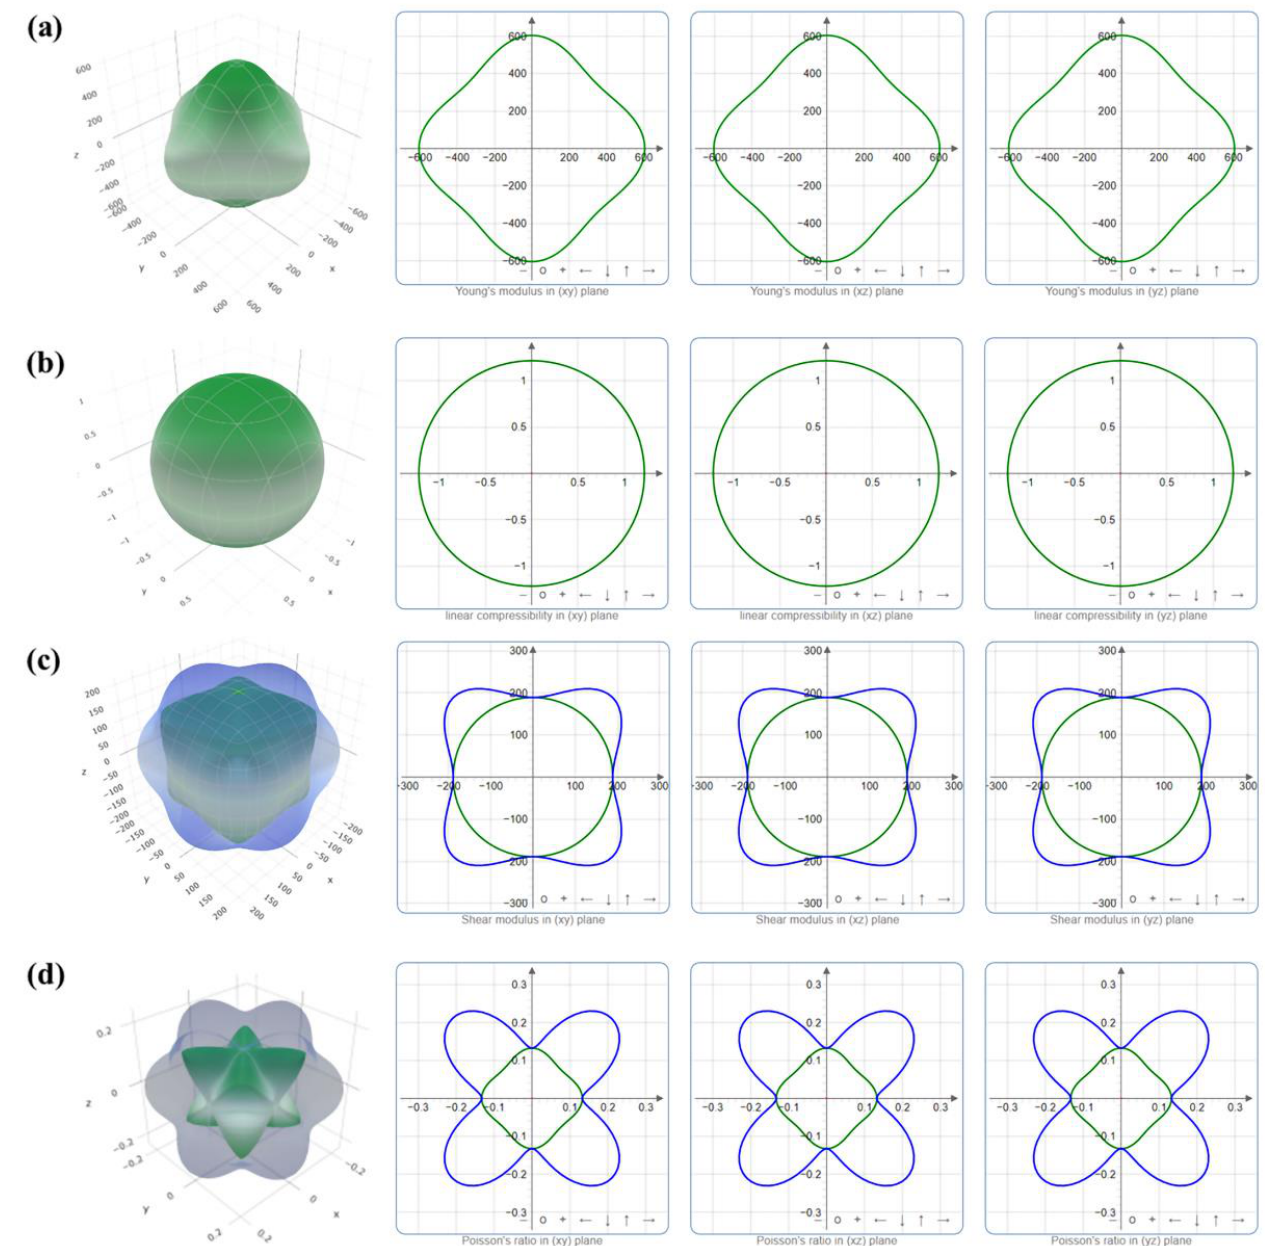
Figure 5. The 3D and 2D viewpoints of the TiN bulk ’ s ( a ) Young ’ s modulus, ( b ) linear compressibility, ( c ) shear modulus, and ( d ) Poisson ’ s ratio.